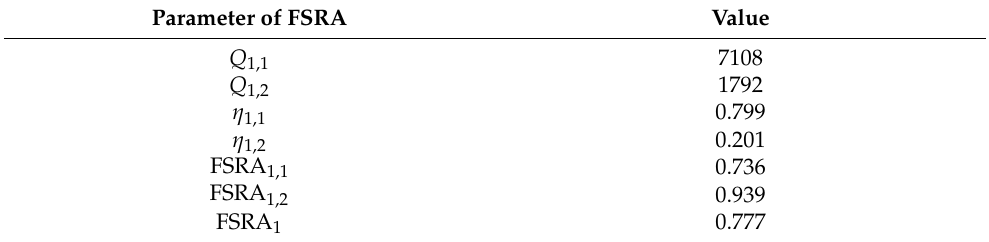
Table 3. FSRA calculation results in the altitude range of 7800–8900 m.